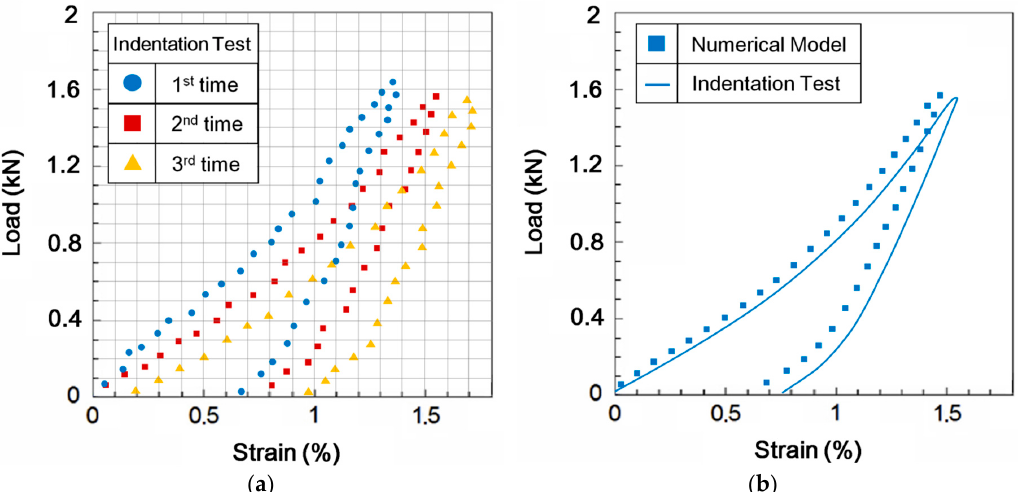
Figure 14. ( a ) Original data of the compressive load-strain curves obtained with the indentation tests; ( b ) Results comparison of the compressive load-strain curves obtained from the 3D SAM model and indentation tests.